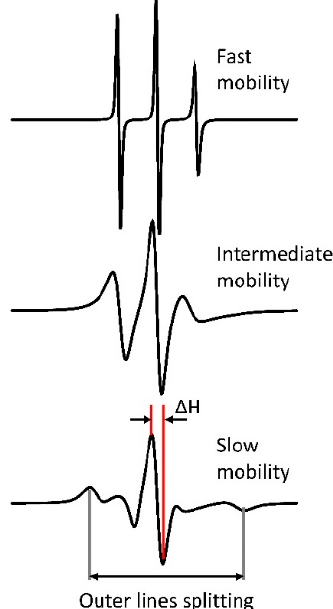
Figure 2. Continuous-wave (CW) electron paramagnetic resonance (EPR) spectra of the nitroxide spin label. The spectra correspond to different ranges of spin-label and protein motion. The coarse parameters, Δ H , and splitting of the outer hyperfine lines are shown in the bottom spectrum. Both parameters depend on the extent of spin label immobilization. The increase in the outer line splitting is due to the contribution from the A zz hyperfine tensor component. Thus, less mobile spin labels lead to broader spectrum.